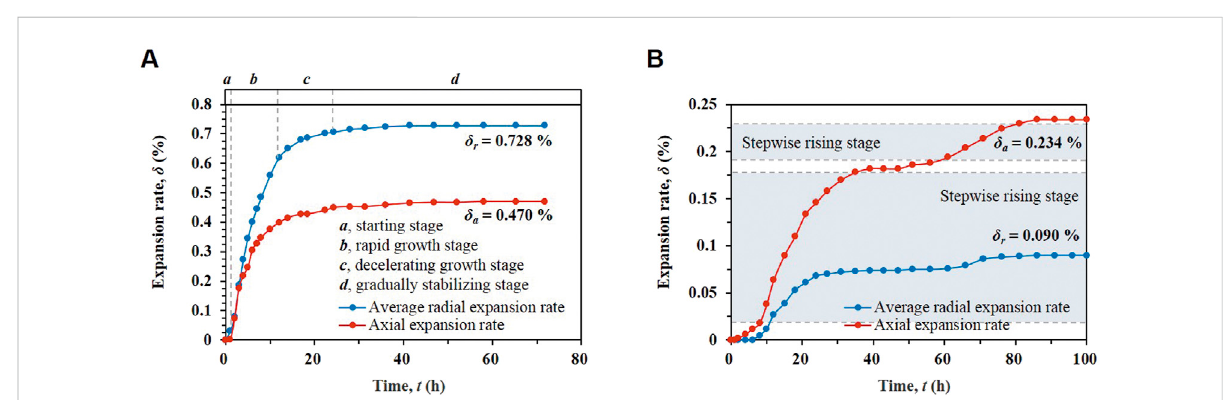
FIGURE 6 Three-way expansion rate time history curve (A) sample with vertical interlayer (B) sample with horizontal